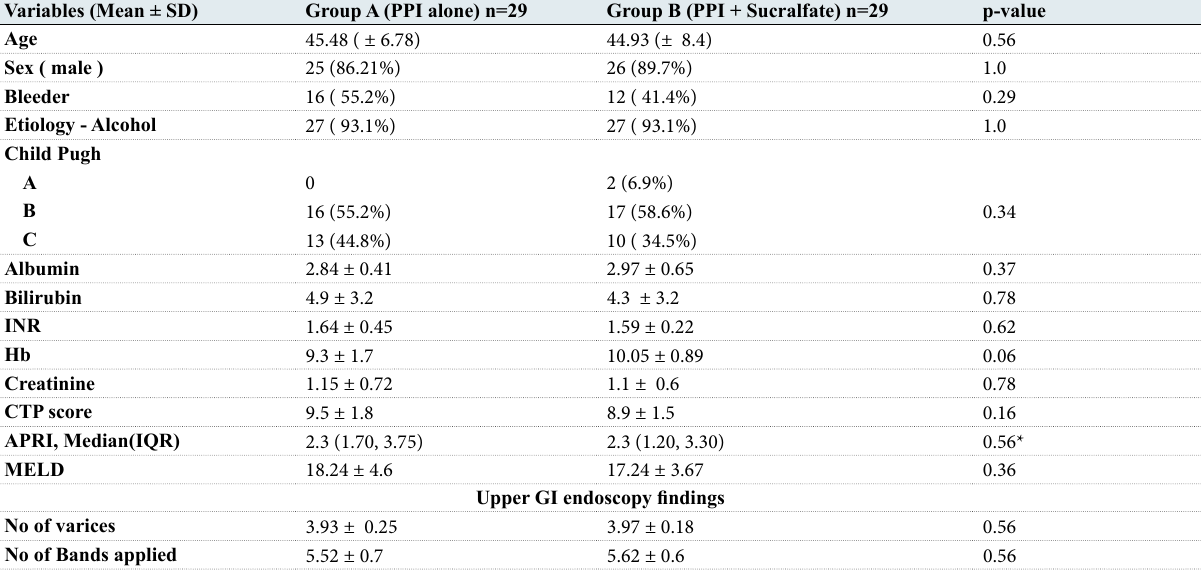
Table 1: Baseline characteristics in the study groups